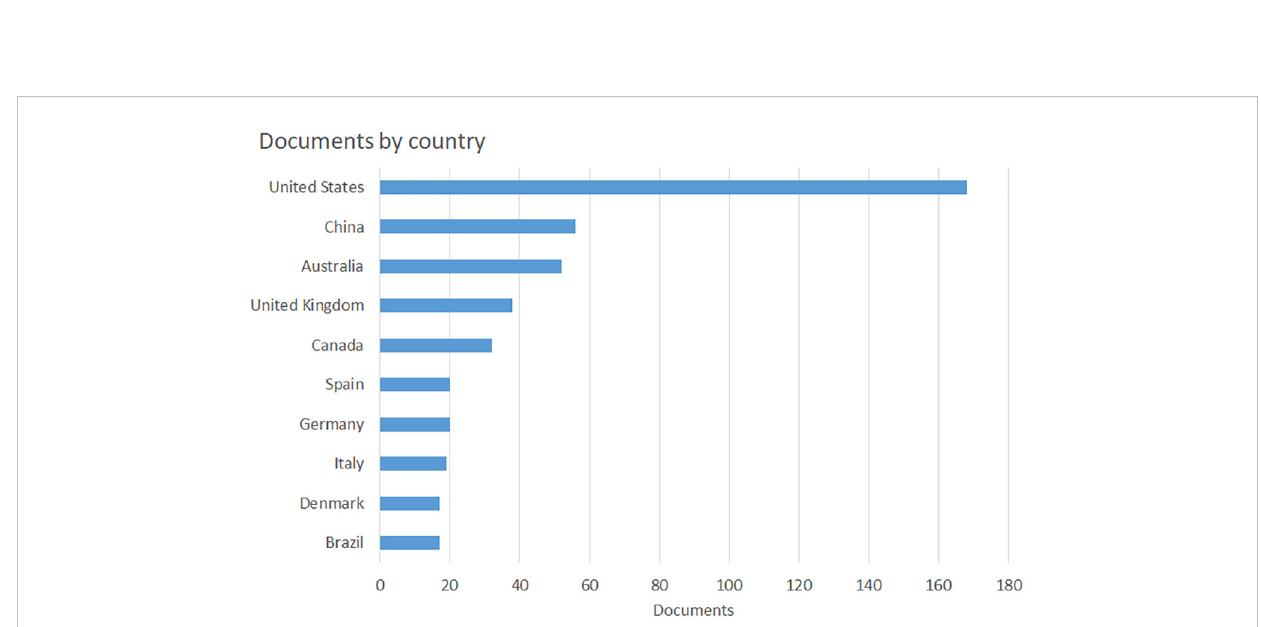
FIGURE 2 Number of publications by country relevant to this research topic (only countries with more than 15 documents are presented). Source: